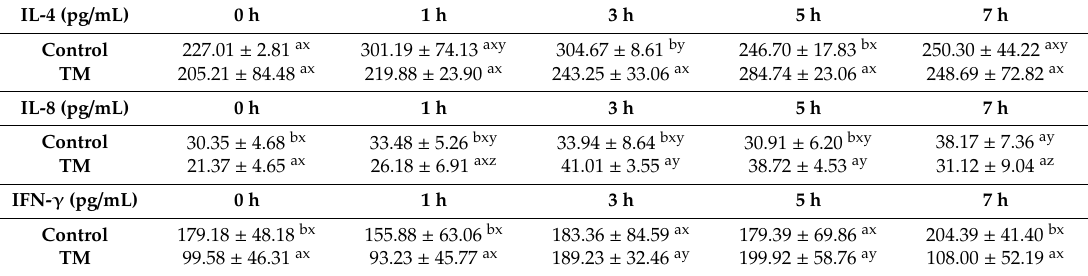
Table 3. E ff ect of thermal manipulation (TM) at 39 ◦ C and 65% RH for 18 h daily during embryonic days 10–18 on IL-4, IL-8, and IFN- γ plasma levels in broiler chickens during acute heat stress (AHS)